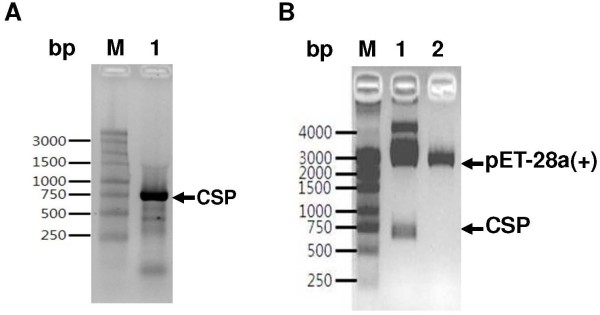
Genetic cloning of circumsporozoite protein gene. (A) Conformation of the PCR product of the circumsporozoite protein gene of Plasmodium vivax Korean isolate. M, Molecular size marker; lane 1, CSP gene. (B) Confirmation of circumsporozoite protein gene in Escherichia coli DH5α by restriction enzyme digestion with BamHI and HindIII. M, Molecular size marker; lane 1; BamHI and HindIII digested plasmid; lane 2, undigested plasmid.